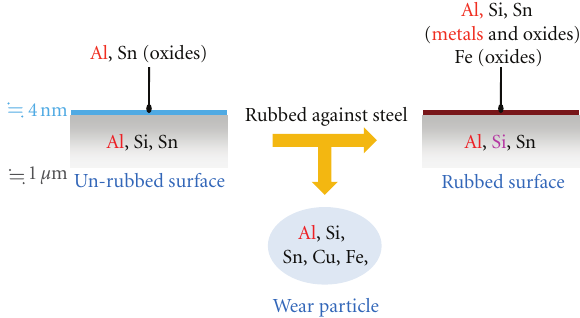
Figure 14: Proposed mechanisms based on surface